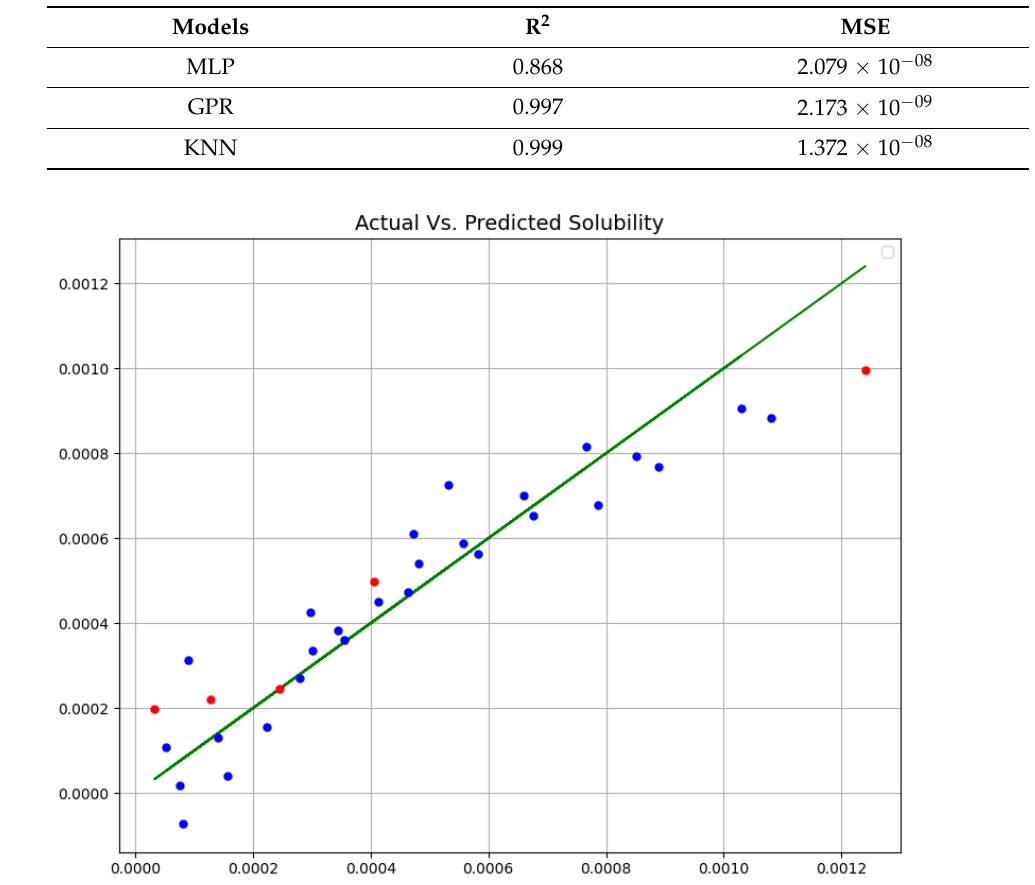
Figure 2. Actual Vs. Predicted Solubility (mole fraction) (MLP).